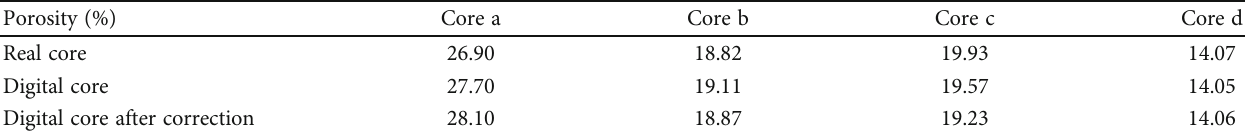
Table 2: Parameters of the sandstones.